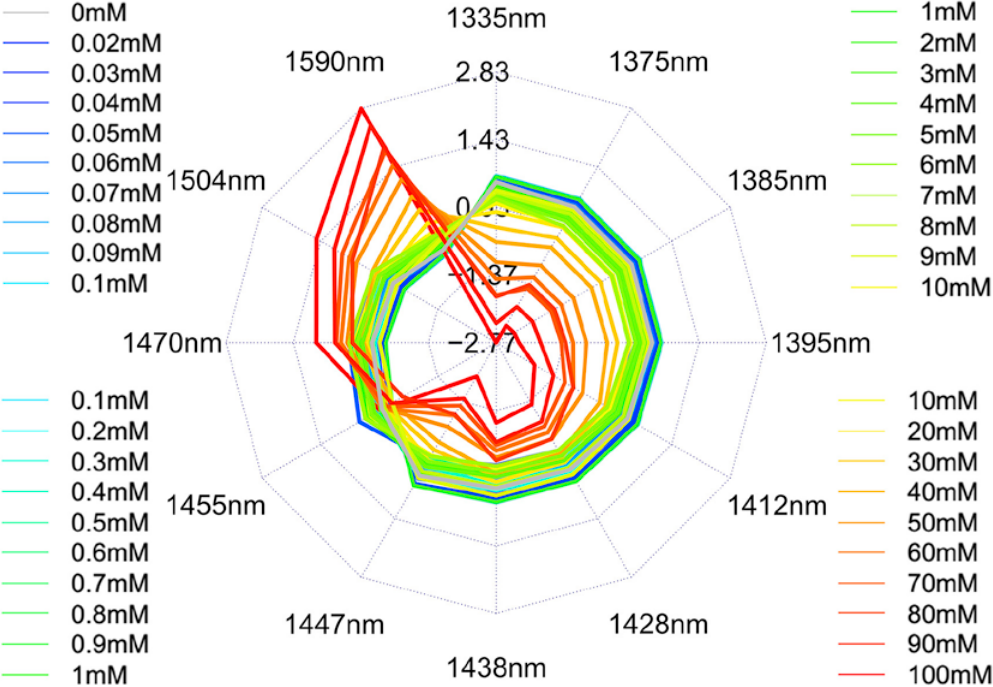
Figure 6. Aquagrams of lactose solutions in 0.02–100 mM concentration range. The radial axes are the 12 water matrix coordinates (WAMACs) and the dynamic changes for low to high lactose concentration from structure maker to structure breaker properties – the water spectral pattern (WASP) changes gradually and the dominance of highly hydrogen-bonded water structures increases with increasing lactose concentration. Figure is adapted from original.